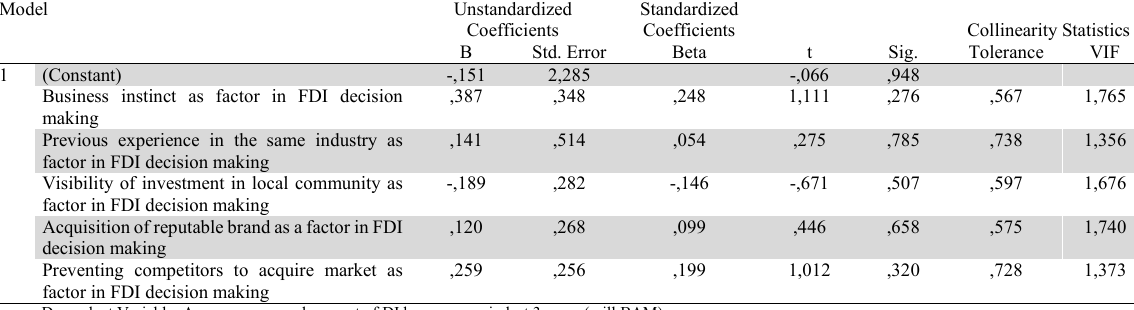
Coefficients in the model with irrational